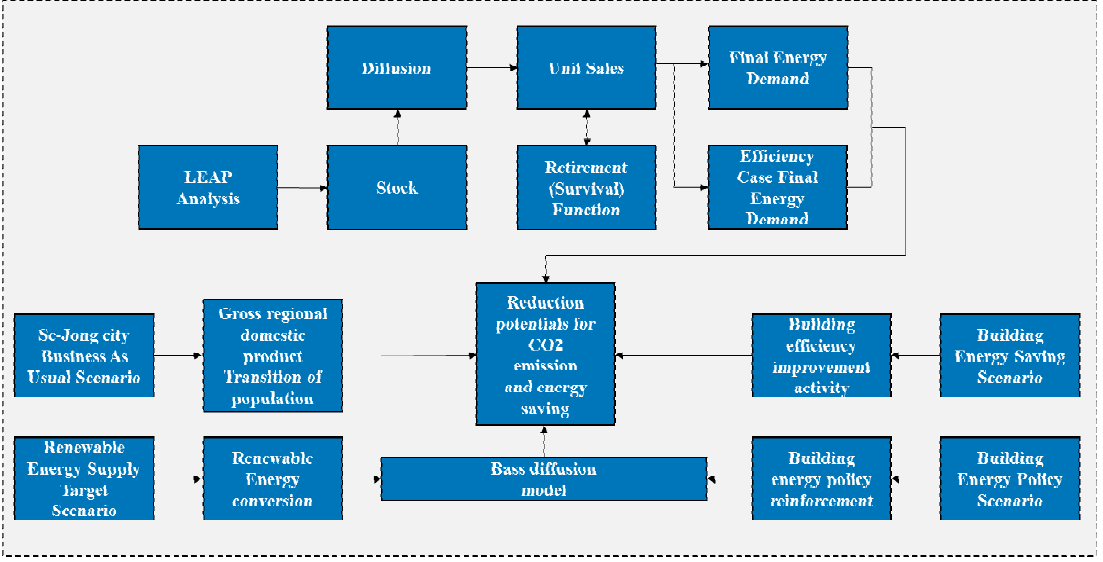
Figure 1. The study processes based on the long-range energy alternatives planning (LEAP) model and Bass diffusion model.